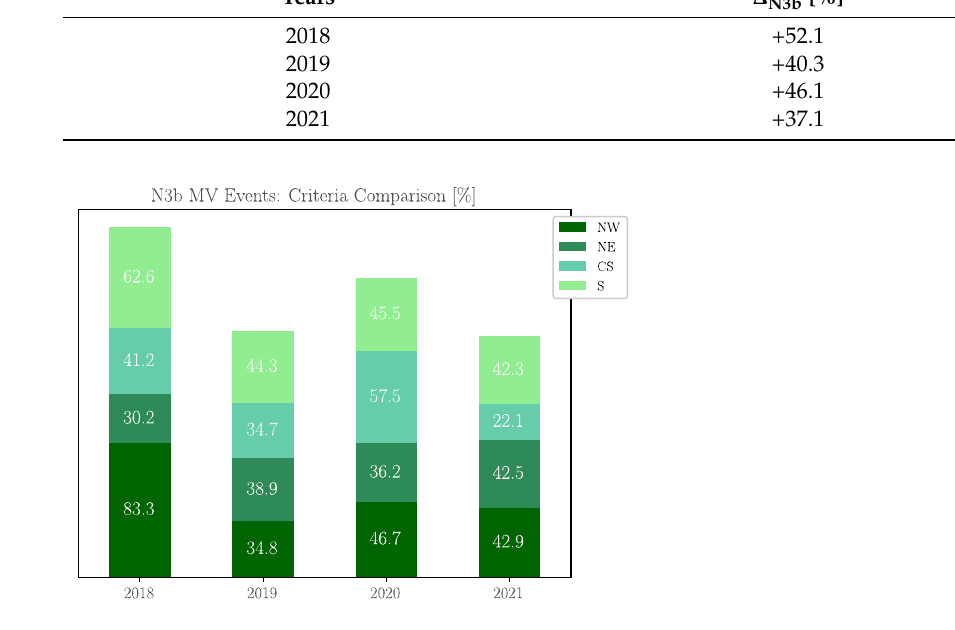
Figure 16. N3b percentual variation: criteria comparison.